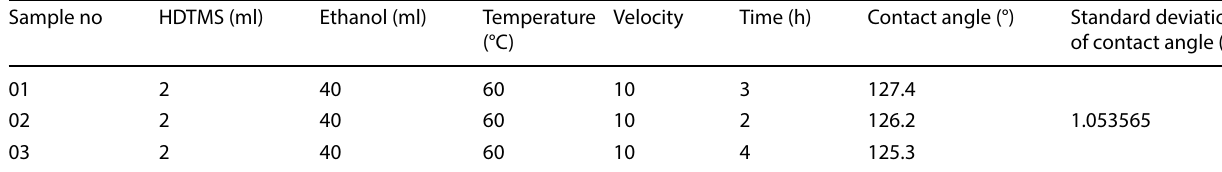
Fig. 15 Physical presence of oil and water droplets a control nonwoven cotton fabric, b HDTMS-treated nonwoven cotton fabric